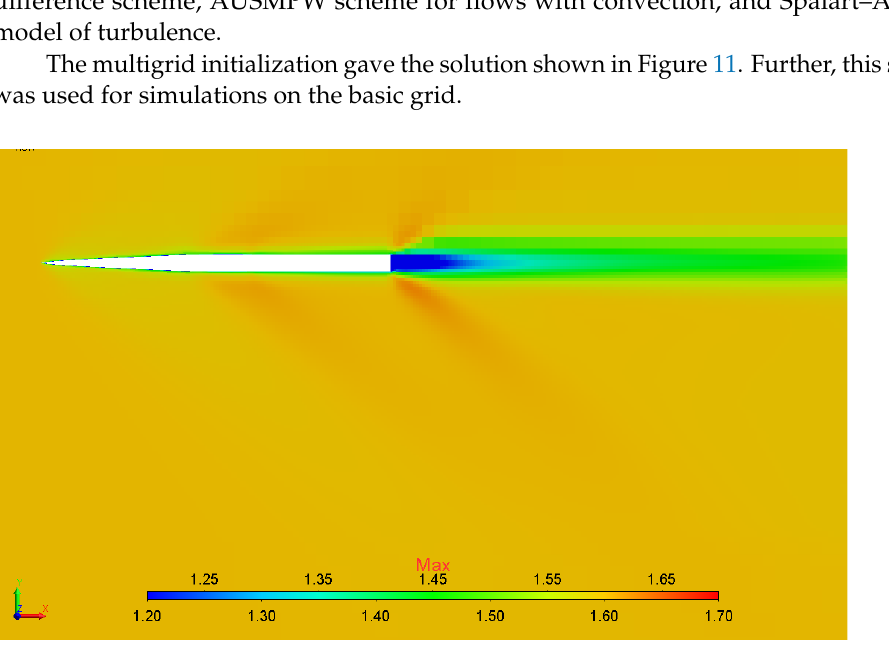
Figure 11. Mach number field, initialization.